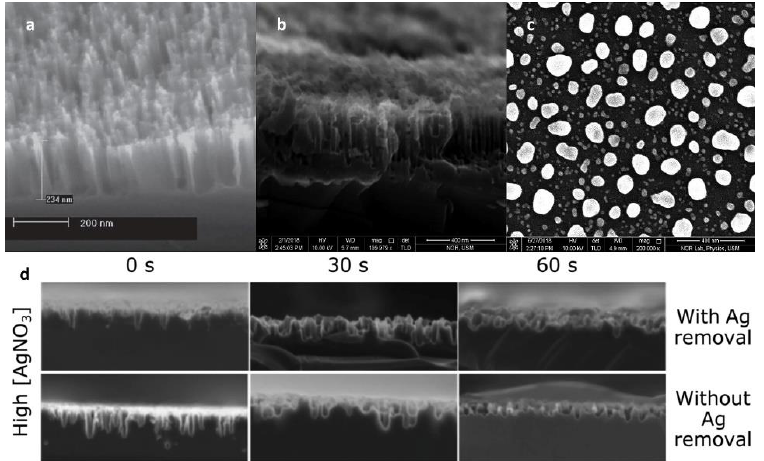
Figure 6. SEM of using different nanoparticles deposited methods to fabricate black silicon. ( a ) The thermal evaporation method using thermal evaporation instruments. Adapted from reference [24], with permission from John Wiley and Sons © 2020. ( b , c ) Using a post-coating heat treatment method to form noble metal nanoparticles. Adapted from reference [46], with permission from Elsevier © 2020. ( d ) Different etching time in high concentration Ag + solution. Adapted from reference [53], with permission from IEEE © 2020.